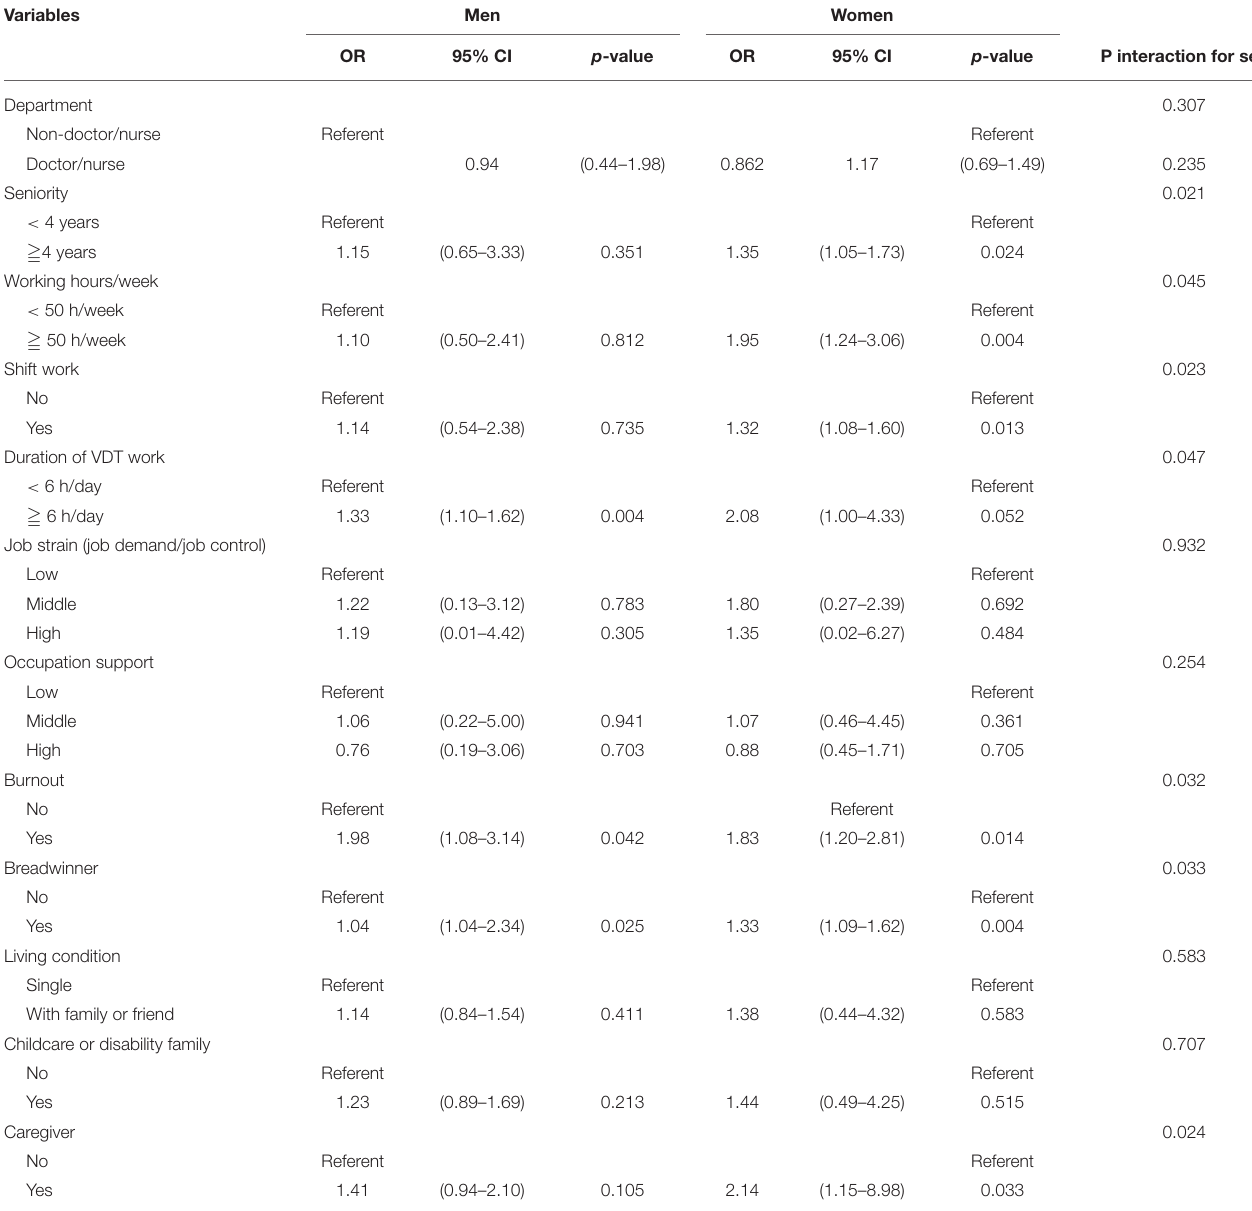
TABLE 4 | The association between insomnia and work/family characteristics by using multiple logistic regression analysis according to sex and the interaction effect.